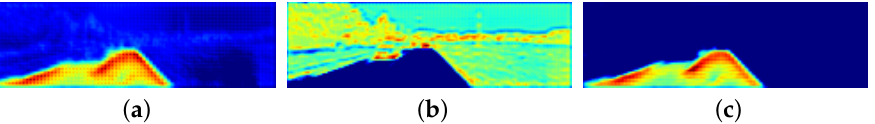
Figure 14. Model—ResNet-18, layer 102, total channels—64, type—convolutional layer. ( a ) Output of channel 4. ( b ) Output of channel 5. ( c ) Output of channel 7. Smooth semantic outputs are generated at this layer.